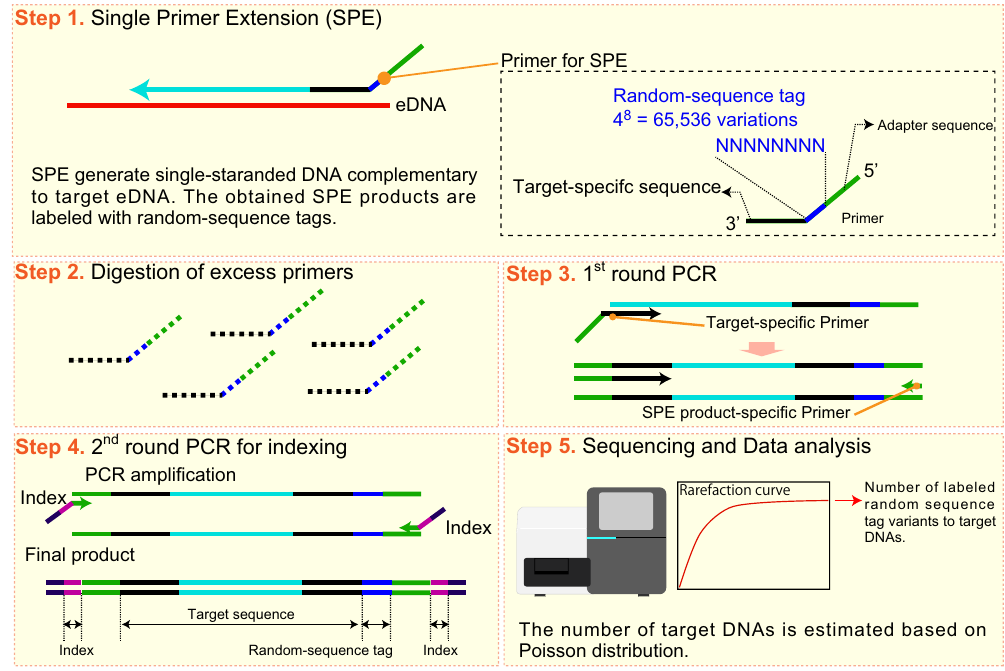
Figure 1. Schematic of quantitative sequencing (qSeq)